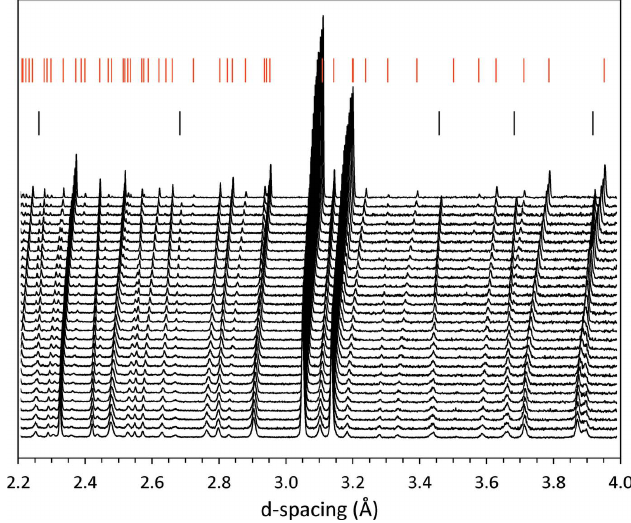
Figure 8 Neutron powder-diffraction data (red circles) measured from phenol hemihydrate at 280 K using HRPD’s 30–130 ms time-of-flight window ( a ) and the 100–200 ms TOF window ( b ). The green line indicates the structural model fit and the purple trace underneath is the difference profile. Black tick marks denote the positions of Bragg